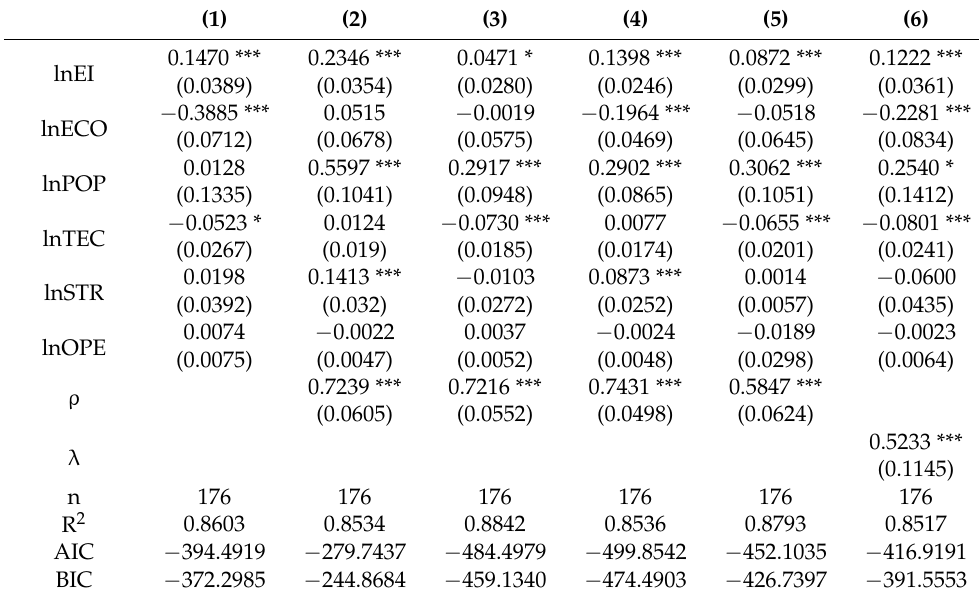
Table 6. The spatial spillover effect of energy intensity on carbon emissions.